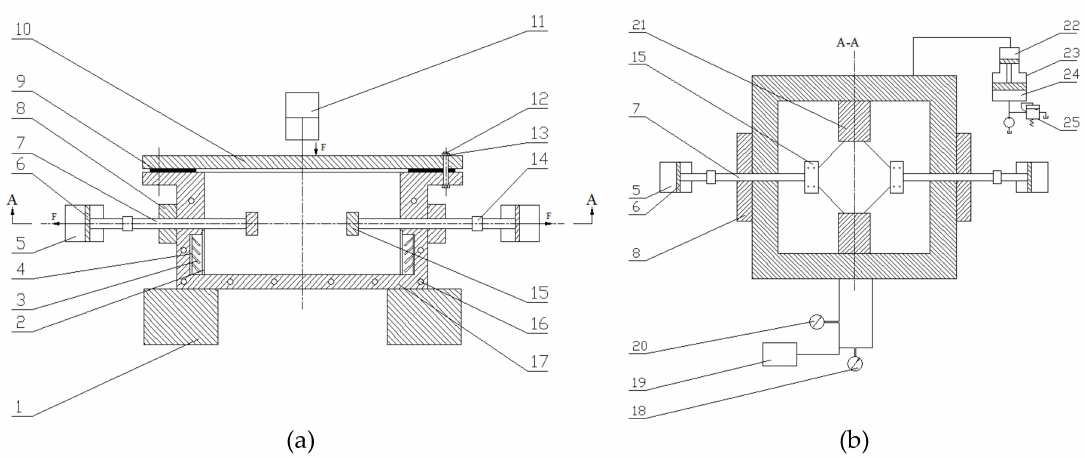
Figure 4. Structural diagram of sheet wrinkling test setup: ( a ) Front view; ( b ) cutaway view